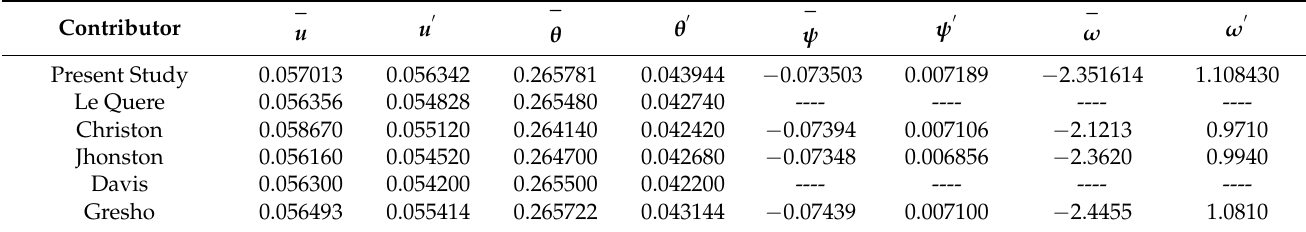
Table 4. Comparison of Point data at reference point 1 with standard results available from Christon et al. [28] Contributor